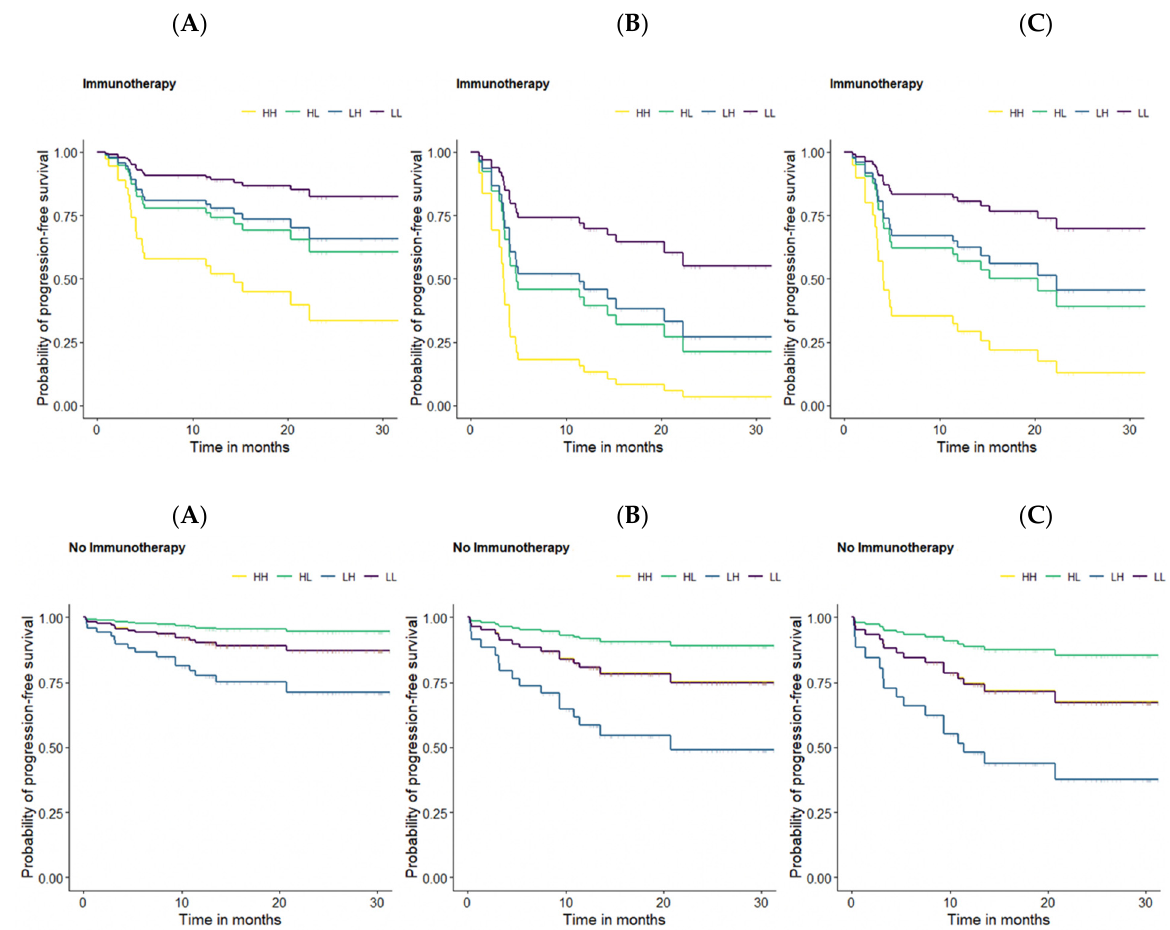
Figure 1. Kaplan-Meier survival curves for PFS based on the defined optimal cut-off values for PT SUVmax, and volume. HH = patients with an SUVmax and a volume of primary tumor higher than their respective cut-off-value (yellow). HL = patients with a SUVmax higher and a volume of primary tumor lower than the respective cut-off-value (green). LH = patients with a SUVmax lower and a volume of primary tumor higher than the respective cut-off-value (blue). LL = patients with a SUVmax and a volume of primary tumor lower than their respective cut-off-value (purple). Survival curve A: mean age, mean TLG, no lymphangiosis, and clinical stage I-III for all patients. Survival curve B: mean age, mean TLG, lymphangiosis, and clinical stage I-III for all patients. Survival curve C : mean age, mean TLG, no lymphangiosis, and clinical stage IV for all patients.